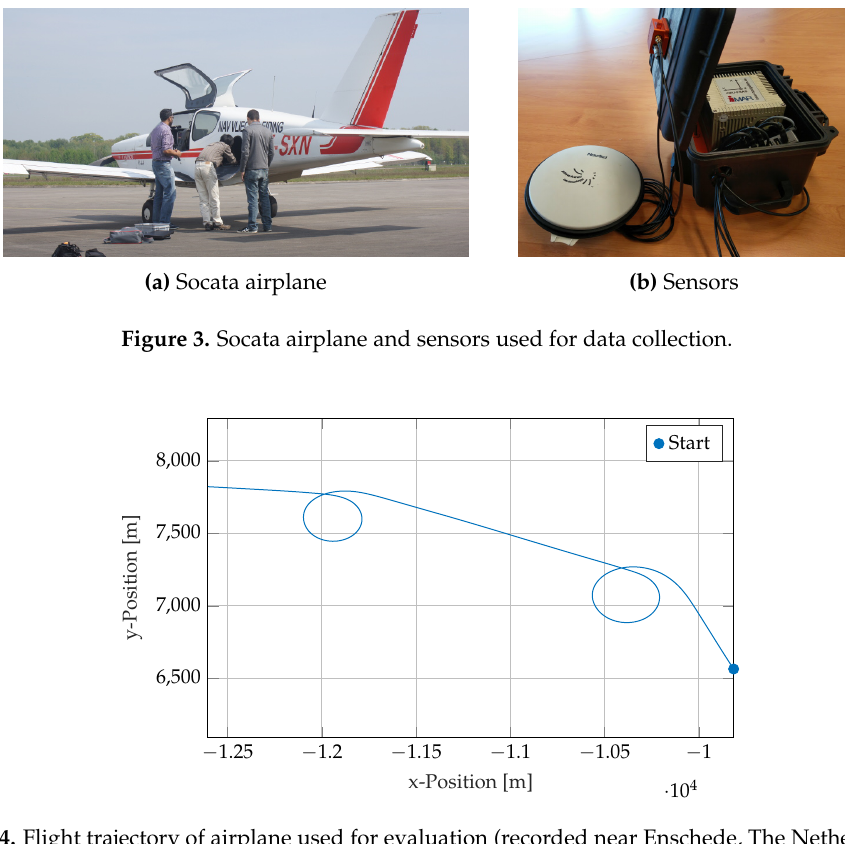
Figure 4. Flight trajectory of airplane used for evaluation (recorded near Enschede, The